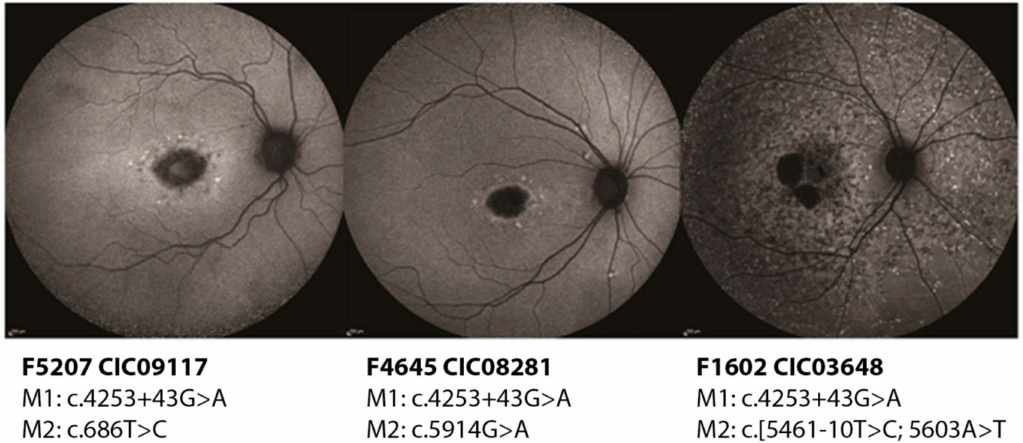
Figure 1. Short wavelength autofluorescence images of the right eyes of three patients carrying the deep-intronic variant c.4253 + 43G > A. While CIC09117 (47 years old) and CIC08281 (45 years old) show a milder phenotype with localized lesions, CIC03648 (26 years old) has clearly a more extensive disease. CIC09817 harbors c.4253 + 43G > A together with c.5603A > T, which is a well-known